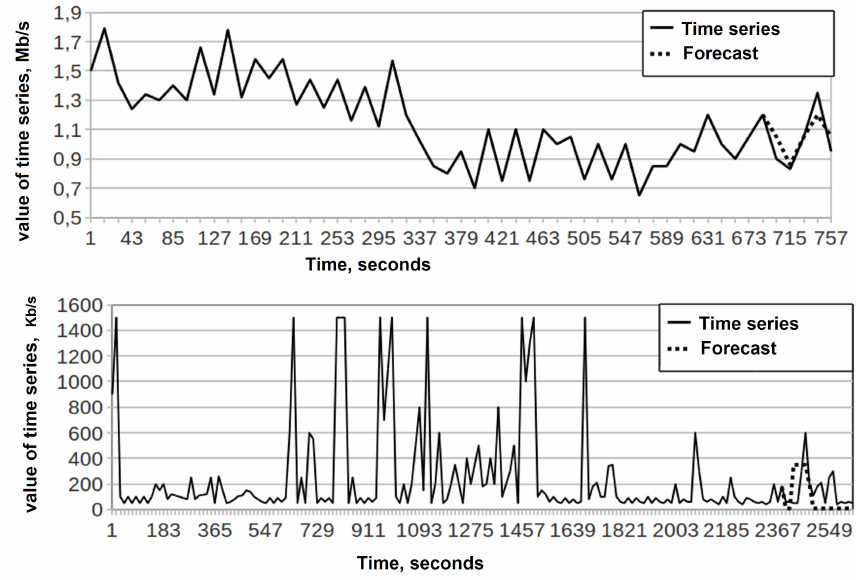
Figure 10. Examples of time series traffic of computer